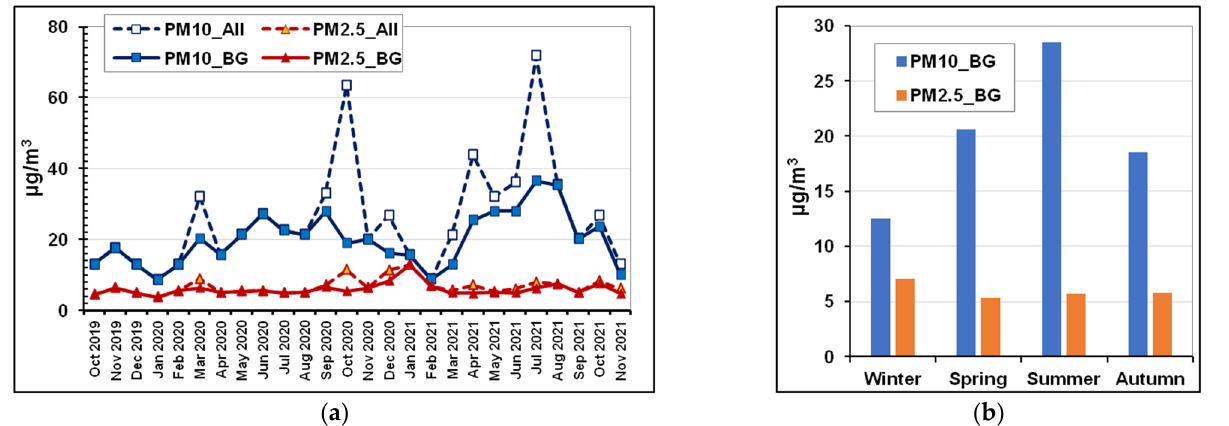
Figure 3. Intra-annual changes in the average (All) and background (BG) values of the aerosol concentration of PM 10 and PM 2.5 : ( a ) by month; ( b ) by season (on average for two years of observa-